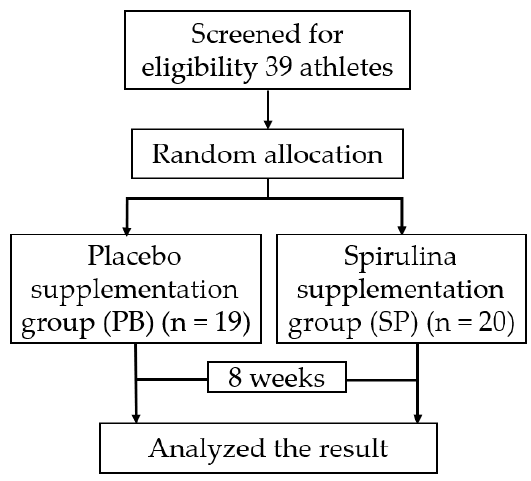
Figure 1. An experimental flow graph; the participants’ grouping and flow of procedure.